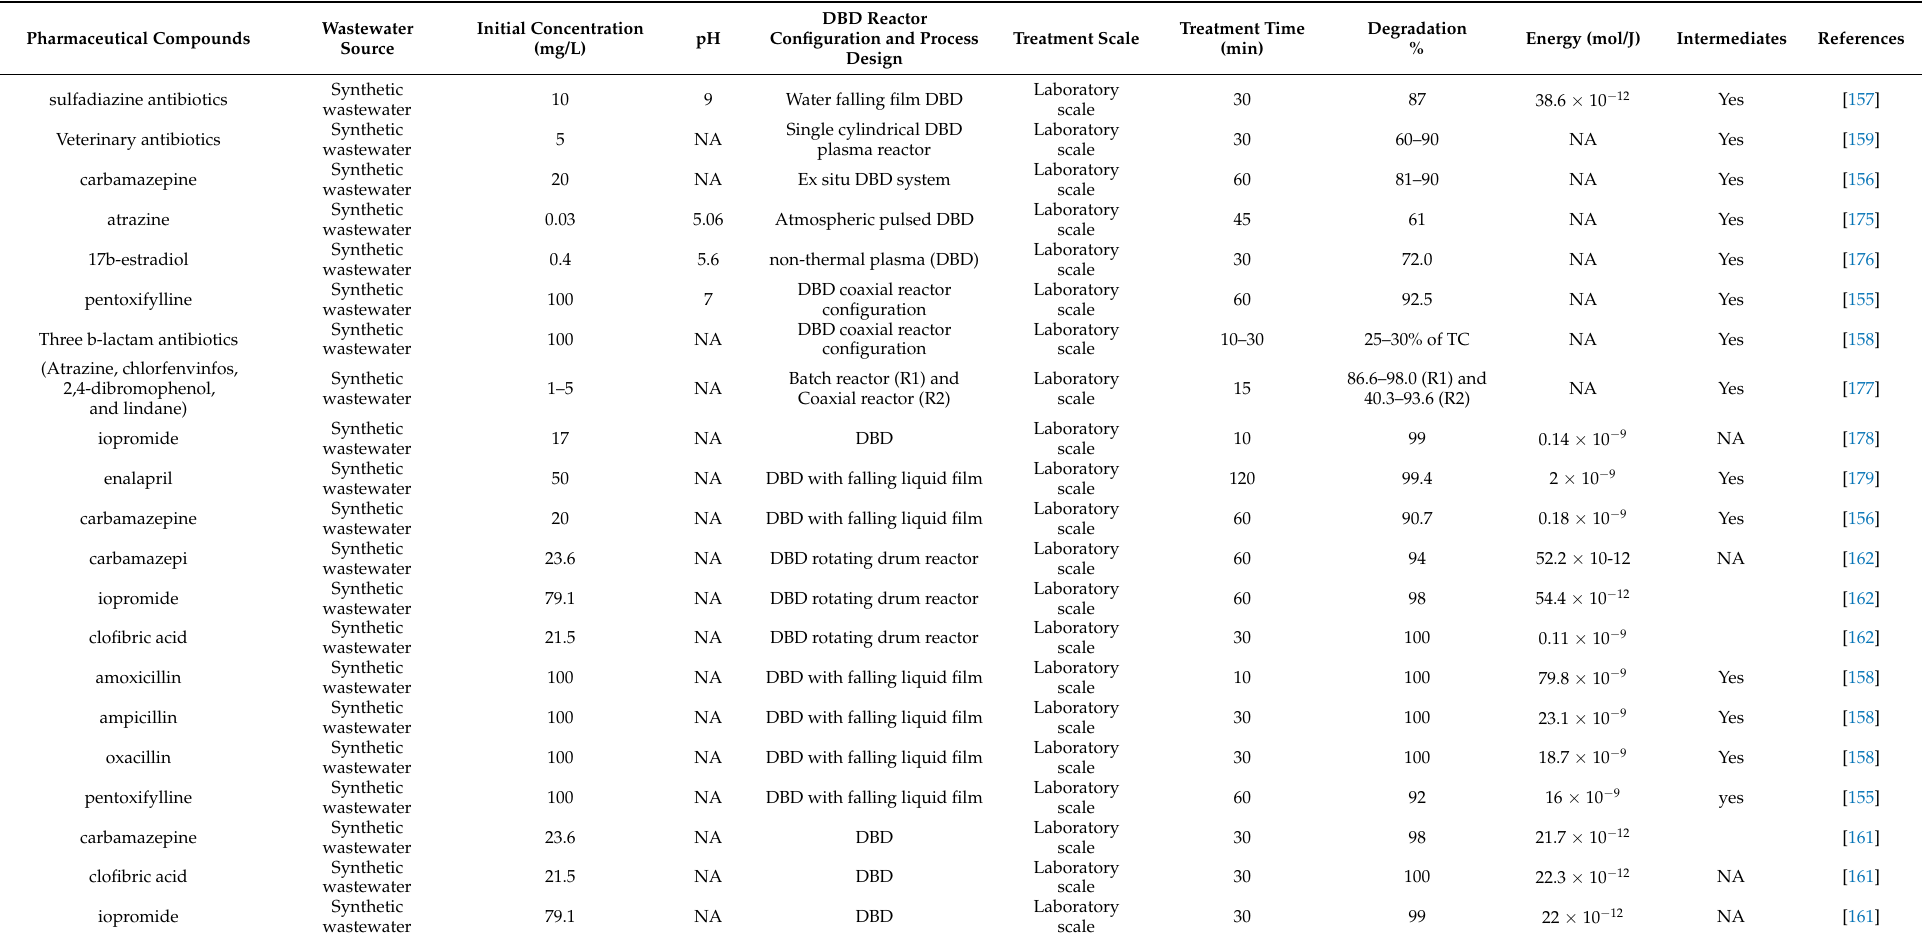
Table 3. Degradation of pharmaceutical compounds by various dielectric barrier discharge